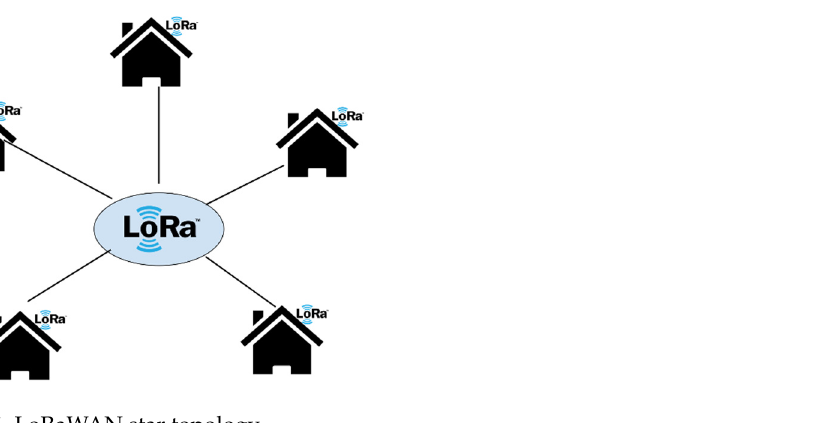
Figure 6. LoRaWAN star topology.